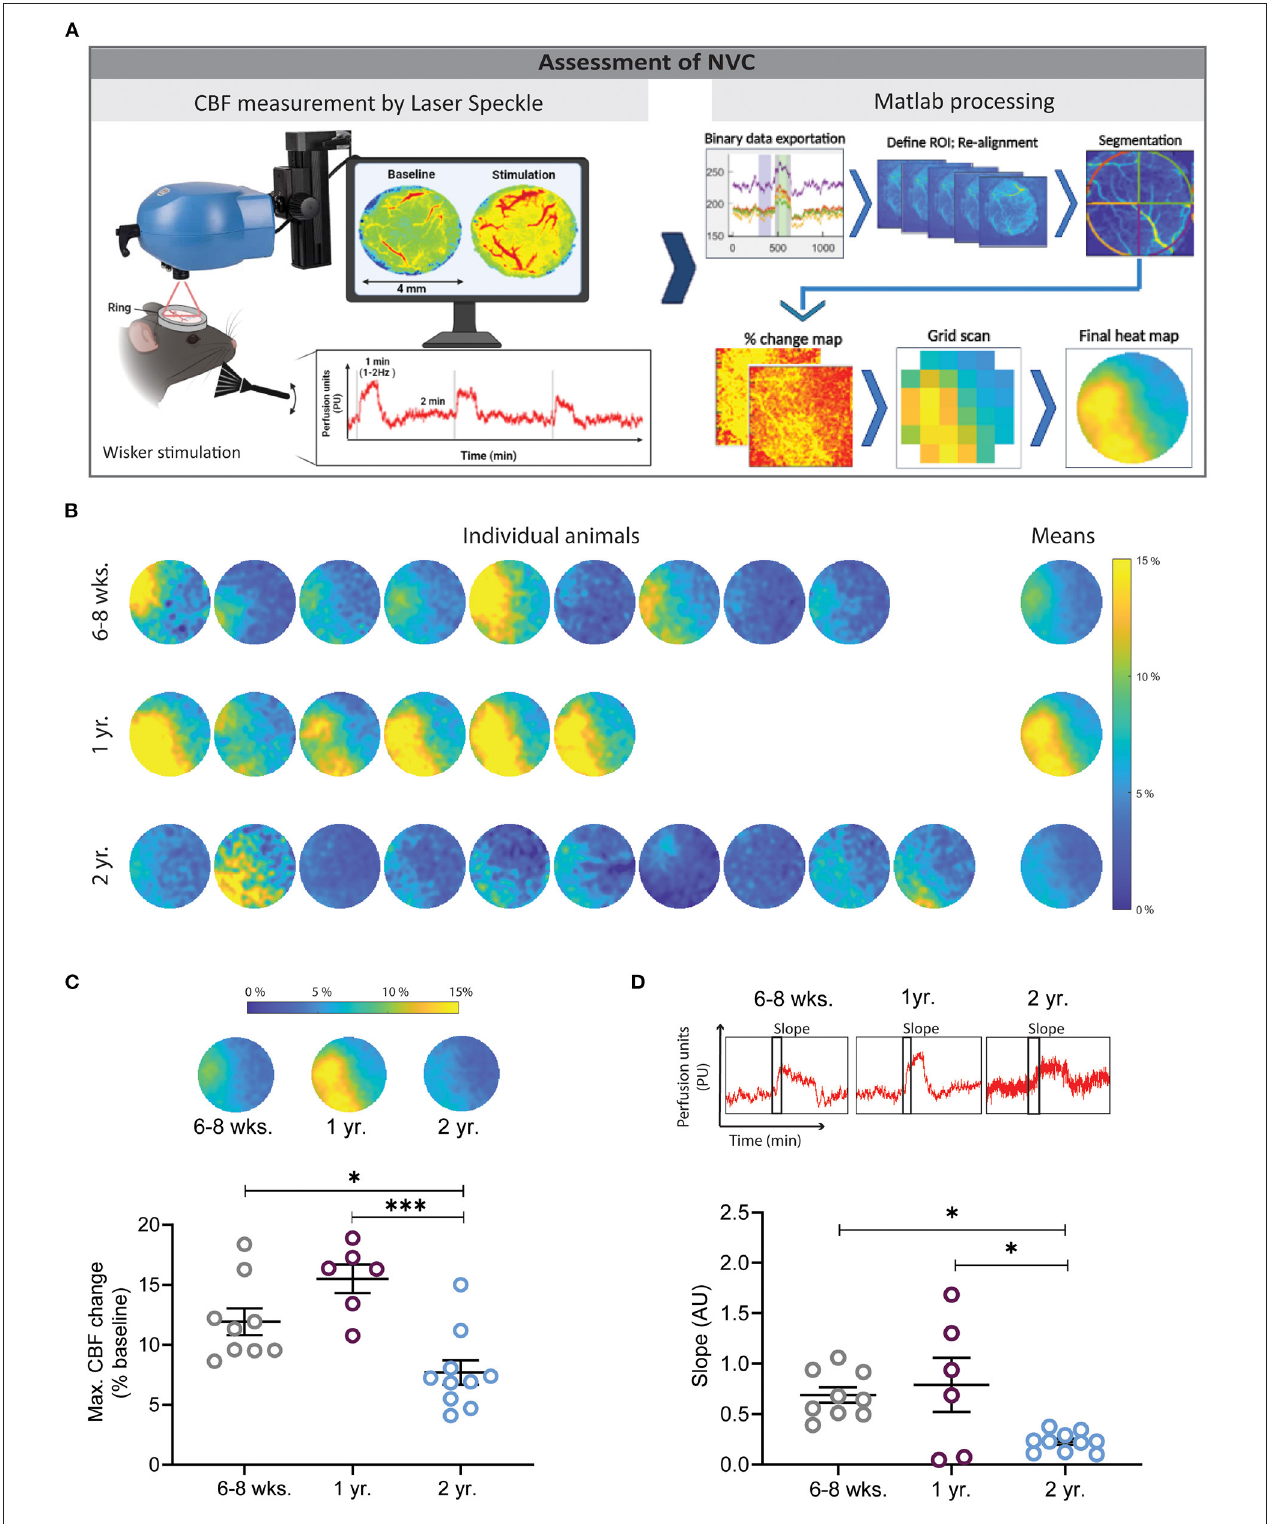
FIGURE 1 | Assessment of neurovascular coupling (NVC) using laser speckle contrast imaging (LSCI) and a Matlab-based analysis pipeline. (A) Experimental setup for whisker stimulation and data analysis. Data visualization with LSCI shows a flow map and a perfusion trace (left), data processing steps show binary data